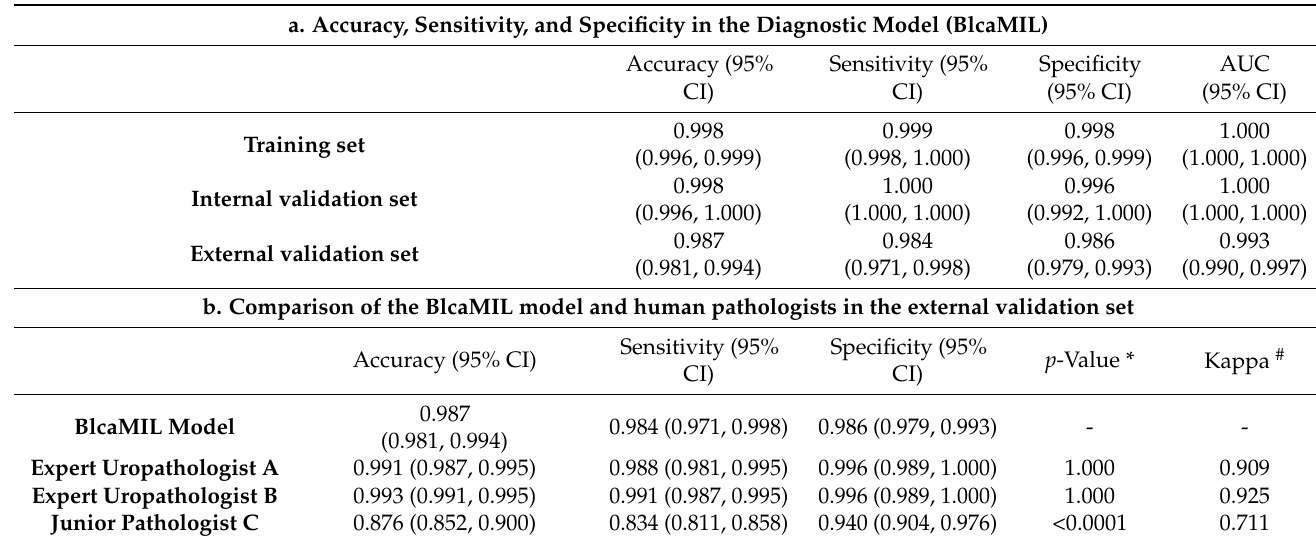
Table 2. Accuracy, sensitivity, specificity, and AUC of the diagnostic model (BlcaMIL) and human